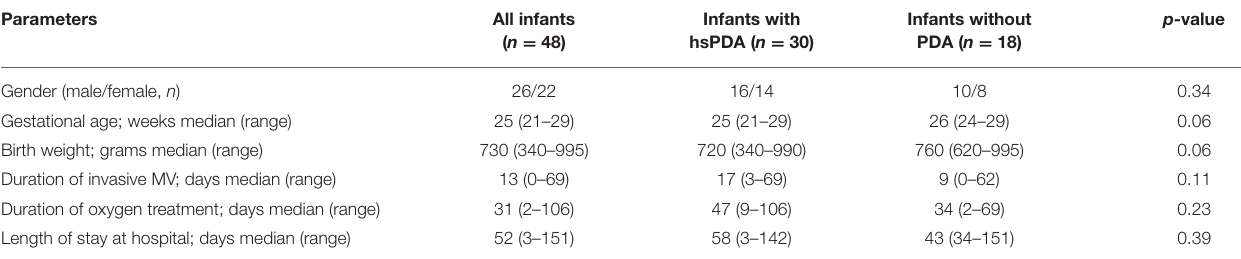
TABLE 2 | The demographic data of all infants.